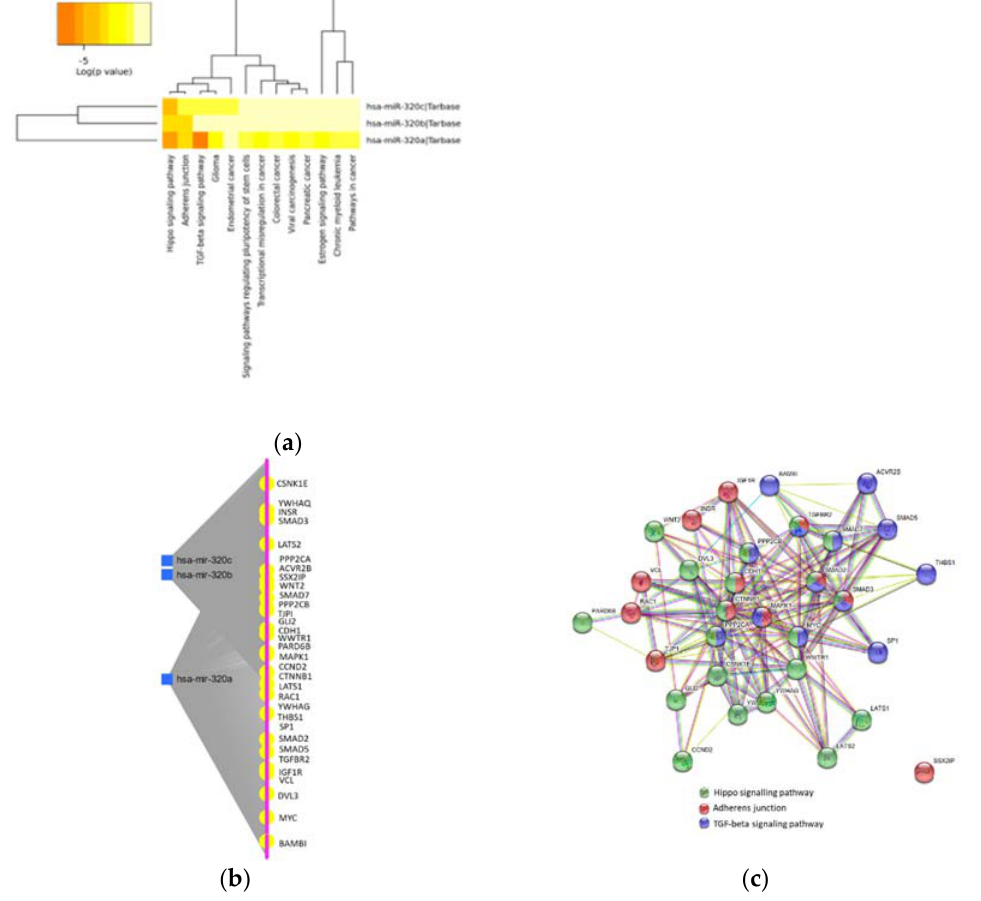
Figure 2. MicroRNA ( MiRNA) expression in COVID ‐ 19 patients with moderate and severe respiratory failure. ( a ) Volcano plots and ( b ) graph showing number of dysregulated miRNAs ( p .adj < 0.05) in the peripheral blood of patients with mod ‐ erate ( n = 11) and severe ( n = 10) respiratory failure induced by COVID ‐ 19 infection at the acute stage and 7 days later. ( c ) Color blot showing different miRNA expression and ( d ) graphs showing differences in miR ‐ 320a, miR ‐ 320b and miR ‐ 320c expression between patients with severe respiratory failure induced by COVID ‐ 19 infection and healthy controls ( n = 8). ( e ) Fold change expression of miR ‐ 320a, miR ‐ 320b and miR ‐ 320c of patients with moderate and severe respiratory failure induced by COVID ‐ 19 infections at acute stage and 7 days later.